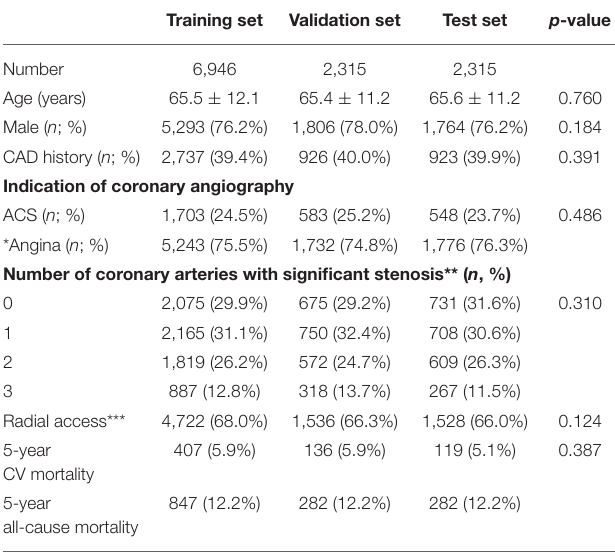
TABLE 1 | Baseline characteristics of the study population.